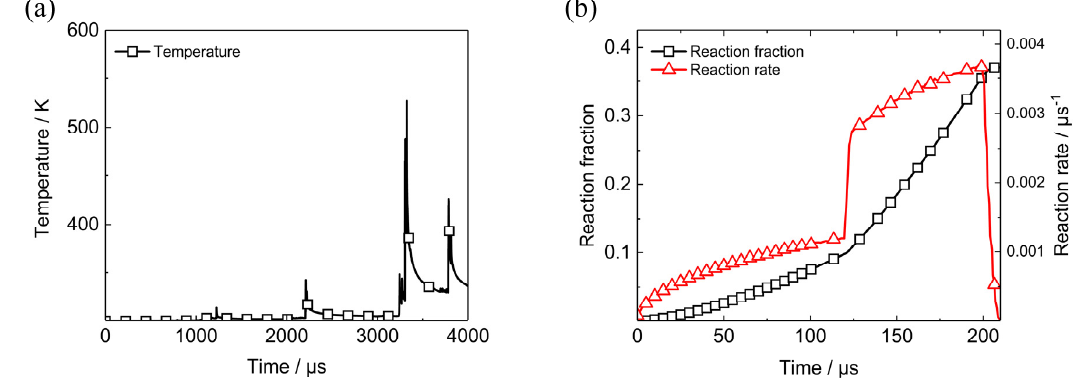
Figure 19. Temperature and reaction process in Element B. ( a ) Temperature history on the microcrack surface, ( b ) reaction fraction and reaction rate.